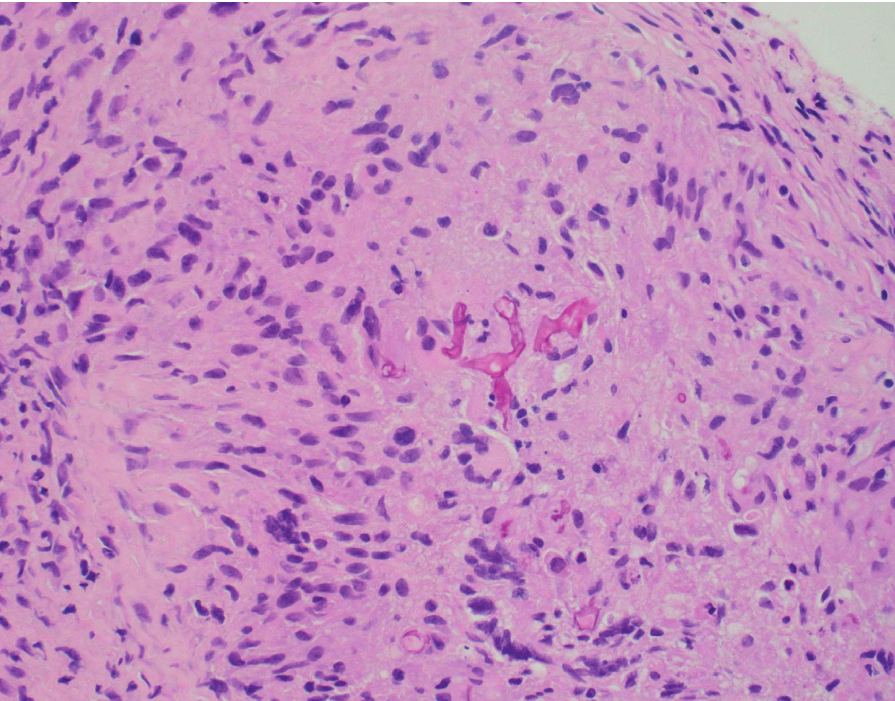
Figure 3: H&E-stained tissue section showing broad aseptate fungal hyphae branching at right angles in a background of inflammatory and epithelial cells.